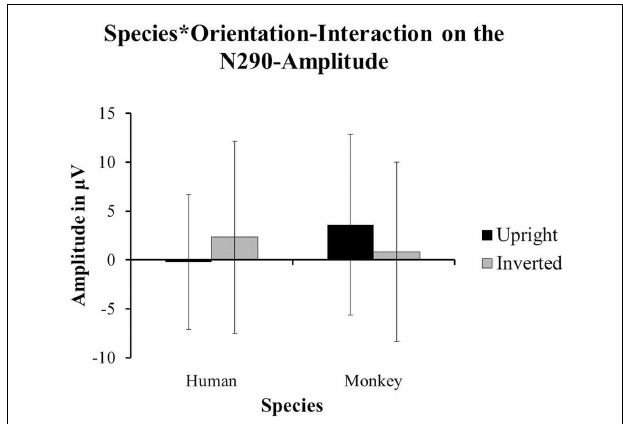
FIGURE 3 |The data from our group of 1-year-olds showed a tendency towards an interaction of Species and Orientation on the amplitude of the N290 [ F (1, 14) = 3.36, p = 0.088]. The upright human faces ( ± SD) yielded more negative responses than the inverted human faces ( ± SD). However, the inverted monkey-faces ( ± SD) yielded the more negative responses compared to the upright monkey-faces ( ± SD).